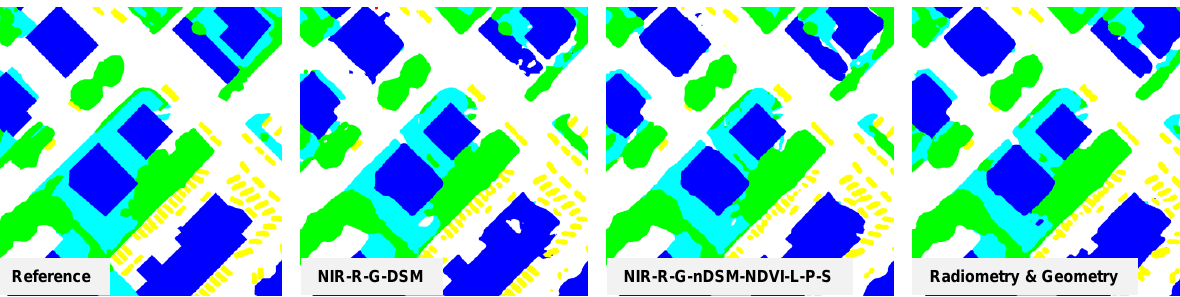
Figure 7. Visualization of the reference labeling and the results for semantic segmentation when using the original data (i.e. only the NIR, R, G and DSM feature maps), when using a specific subset of all defined feature maps (here the NIR, R, G, nDSM, NDVI, L, P and S feature maps) and when using all defined feature maps (from left to right): the color encoding addresses the classes Impervious Surfaces (white), Building (blue), Low Vegetation (cyan), Tree (green) and Car